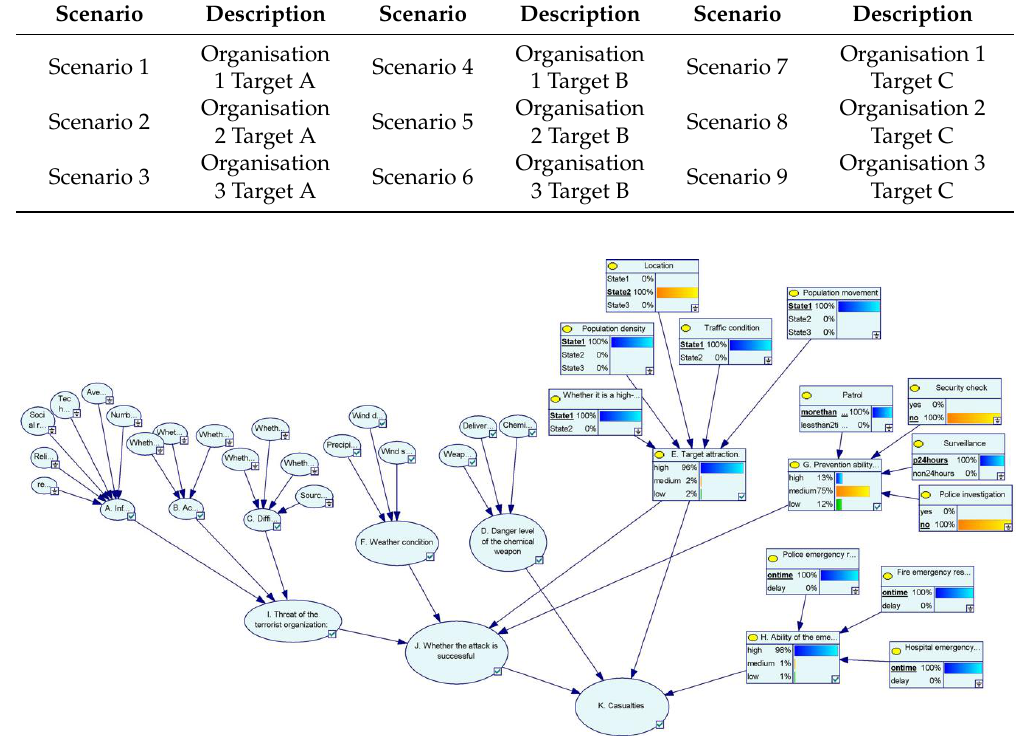
Figure 4. Node status of Target A in Bayesian network.